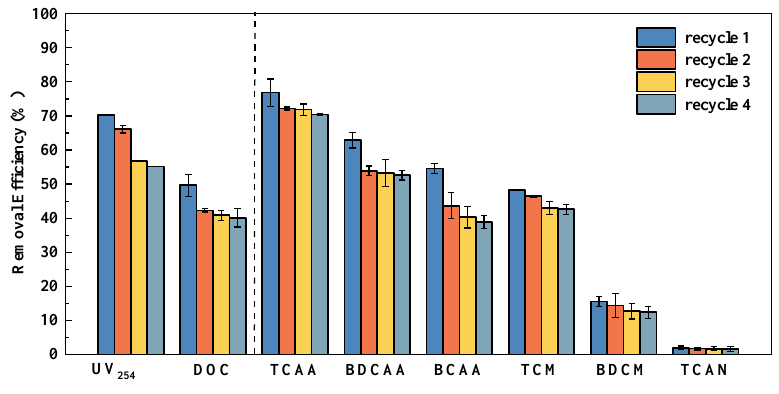
Figure 12. Reuse of RGO-SiO 2 .